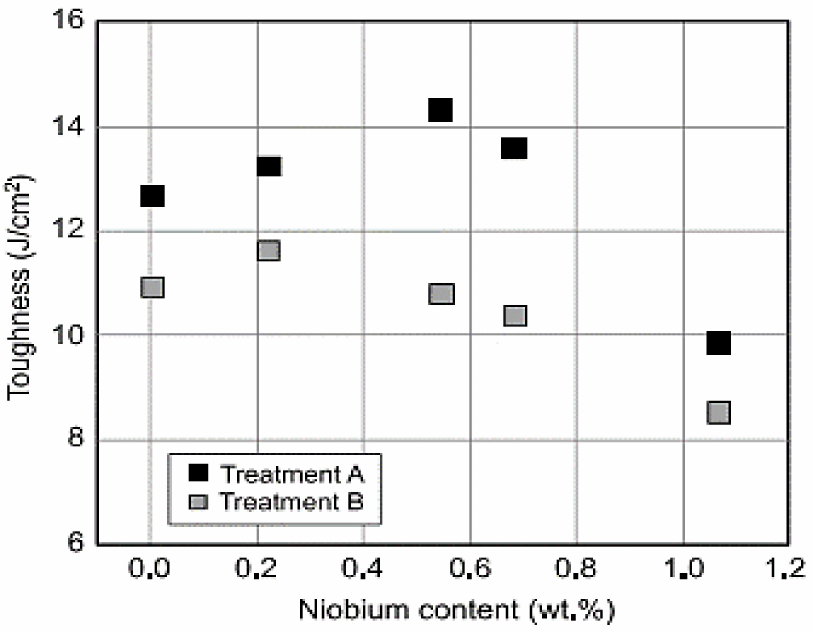
Figure 41. The effectiveness of niobium inclusion and austempering temperature on shock resistance of the samples